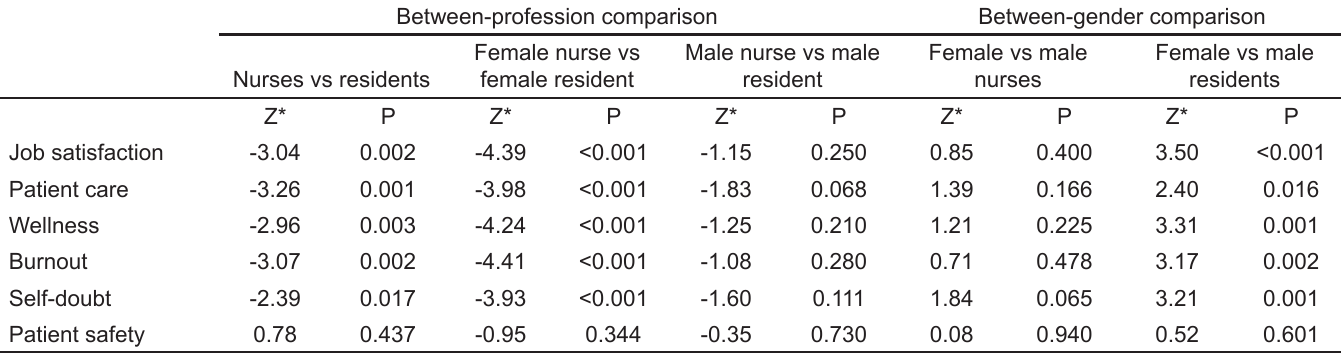
Table 5. Perceived impact of gender bias in interprofessional